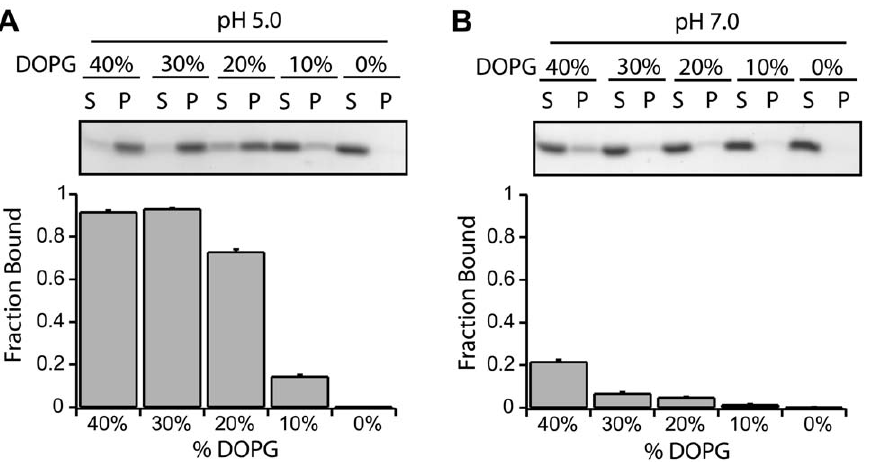
Figure 2. Fis1 D TM membrane binding requires negatively charged lipids. A vesicle sedimentation assay was used to measure fraction of Fis1 D TM bound to lipid vesicles as a function of decreasing concentration of anionic DOPG at pH 5.0(A) or pH 7.0(B). Each panel depicted as in Figure 1 with experiments done in a similar manner with 5 m M protein incubated for 4 hours at 25 u C with 2 mM of 100 nm lipid vesicles (1:400 protein:lipid). Vesicles were made with a constant percentage 60% Br 4 DSPC, and DOPG was replaced by an equimolar amount of DOPC to maintain a constant lipid concentration. Average fraction bound and the standard error of the mean were calculated from n=3 independent measurements.